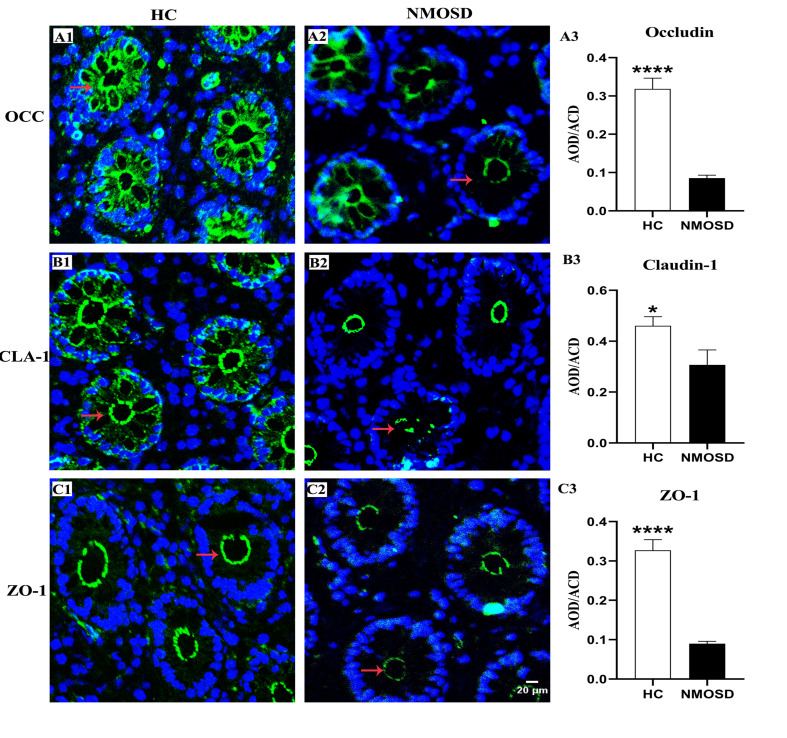
Photomicrograph and histogram showing changes in TJ proteins of the colonic mucosa. Positive immunostaining (arrows, green) for OCC, CLA and ZO-1 of the sigmoid colonic mucosa in the HC and NMOSD groups is shown in (A1,A2), (B1,B2), and (C1,C2), respectively. The nuclei of the epithelium were counterstained with DAPI (blue). The results of the quantitative analysis of OCC, CLA, and ZO-1 are shown in (A3, B3, and C3), respectively. *p < 0.05, ****p < 0.0001 compared with the control group. OCC, occludin; CLA, claudin-1; ZO-1, zonula occludens-1; AOD, average optical density. The scale bar (20 μm) in (C2) is equal to that in (A1,A2), (B1,B2), and (C1).